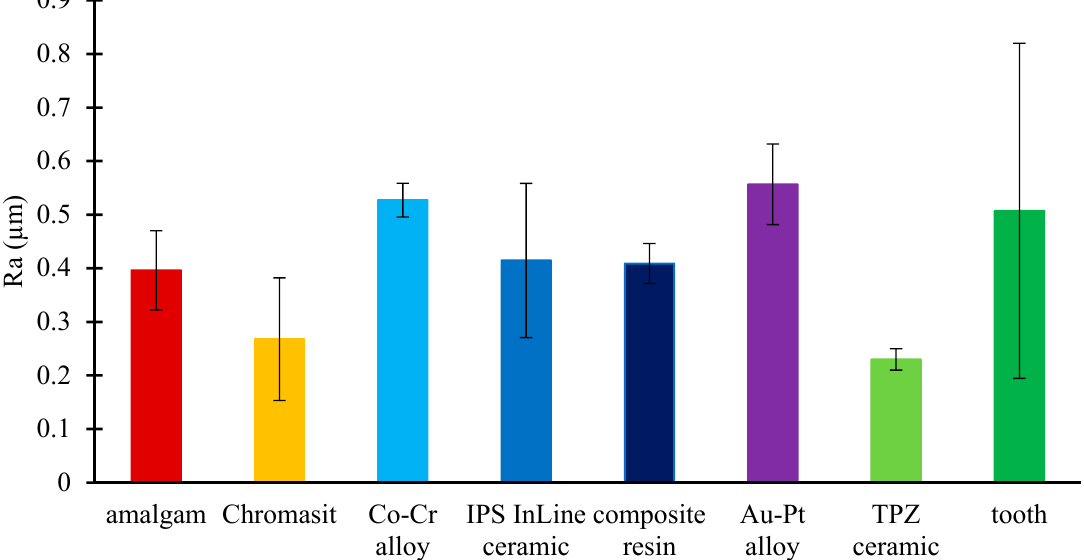
Figure 1. Roughness (Ra) of eight different dental material surfaces: amalgam, Chromasit, Co-Cr alloy, IPS InLine ceramic, resin-based composite, Au-Pt alloy, TPZ ceramic, and tooth.